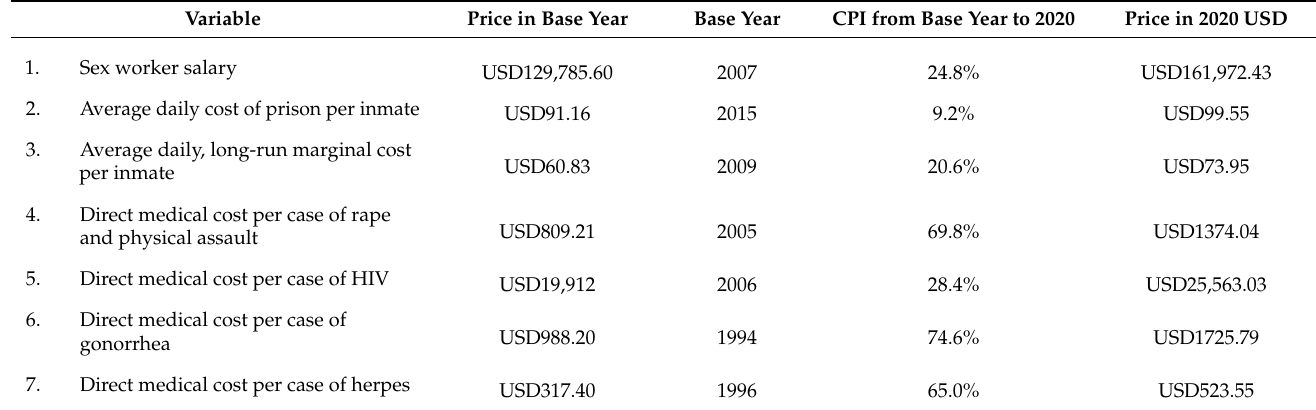
Table 6. CPI-adjusted prices in 2020 USD.